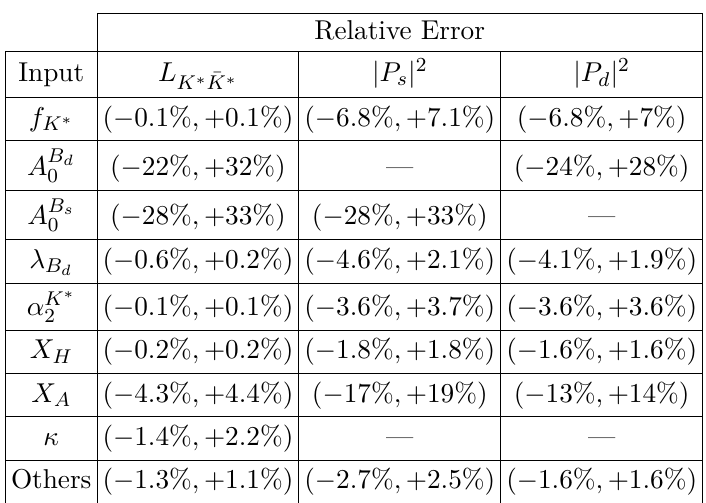
Table 2 . Error budget of L and | P d,s | 2 . The relative error of each theoretical input is obtained K ∗ ¯ K ∗ by varying them individually. The main sources of uncertainty are the form factors, followed by weak annihilation at a significantly smaller